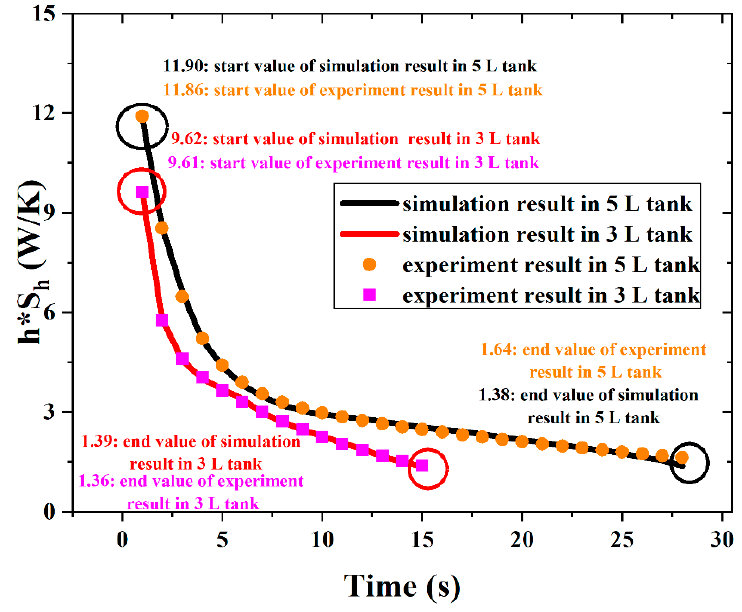
Figure 7. Theoretical and experimental comparison of overall heat transfer coefficient. Comparing the theoretical and experimental results of overall heat transfer coefficient, it can be seen that the fitting effect was accurate. In the fitting effect of the 5 L tank experiment, the initial simulation value of 1.9 W/K maintained the same downward trend as the experimental value and reached 1.64 W/K, while in the fitting result of the 3 L gas tank, the initial simulation value of 9.62 W/K decreased to 1.39 W/K. The error diagram of fitting is displayed in Figure 8, showing a maximum error of 2.92% in the 5 L tank experiment at 8 s, while the minimum error was 0.22% at 11 s, and the average of the error of the whole process was only 1.63%. In the 3 L tank experiment, the maximum error was 2.69% at 6 s, the minimum error was 0.05% at the first second, and the average of the error of the whole process was 1.33%.